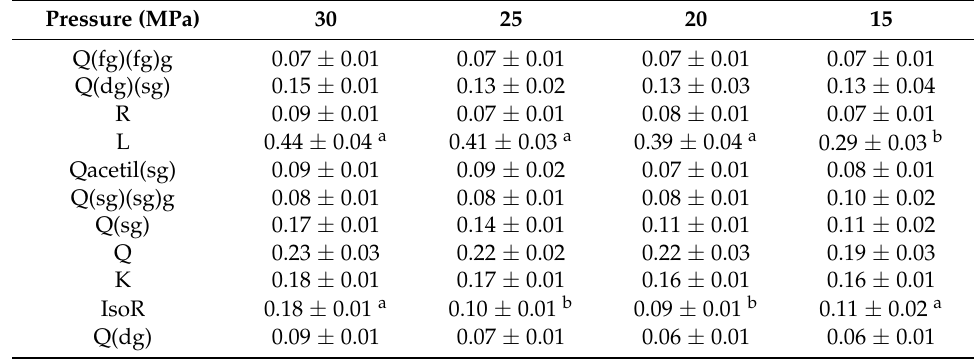
Table 5. Phenol composition (mg/g) of Eruca sativa extract obtained by 8% water SCO 2 at different pressures.